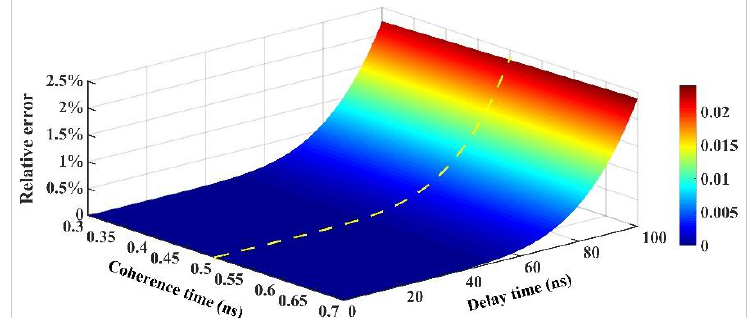
Figure 7. Relative error as functions of coherence time and delay time. The photon intensity was 0.04 photons / s and the yellow dashed line corresponds to the experimental